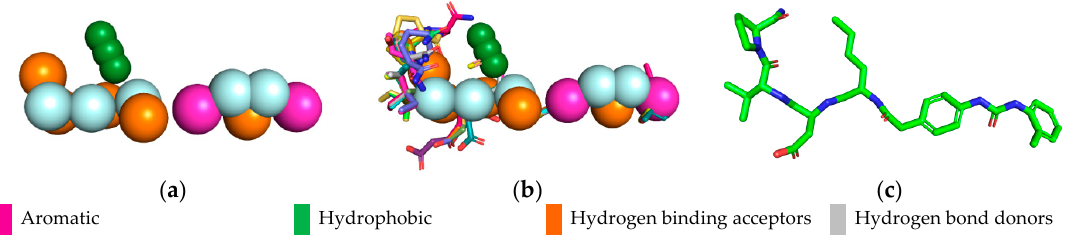
Figure 2. Pharmacophoric model generated with the PharmaGist server. ( a ) Structure 1 (pivot); ( b ) alignment of the 17 structures with better score; ( c ) pharmacophoric features: two aromatic, three hydrophobic, five hydrogen binding acceptors and five hydrogen bond donors. Figure generated with the PyMOL4.5 program. Table 1. Pharmacophoric characteristics of the training set, pIC 50 (pIC 50 = − log IC 50 )